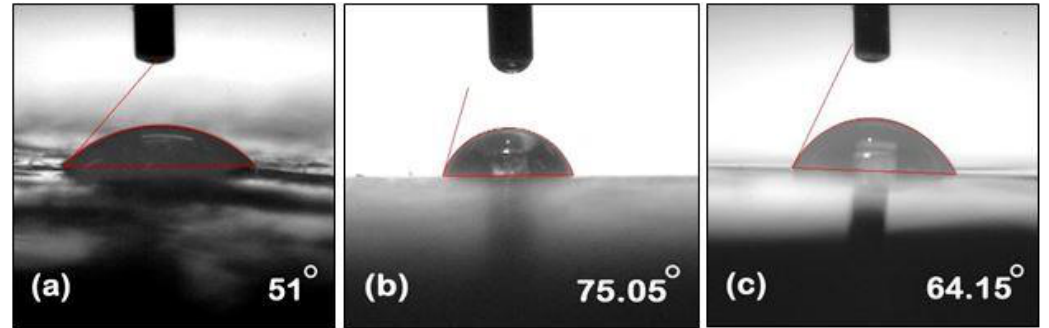
Figure 6. Measurement of contact angle of 30 h aged ( a ) neat epoxy ( b ) epoxy microcomposite, and ( c ) epoxy nanocomposite. and ( c ) epoxy nanocomposite.